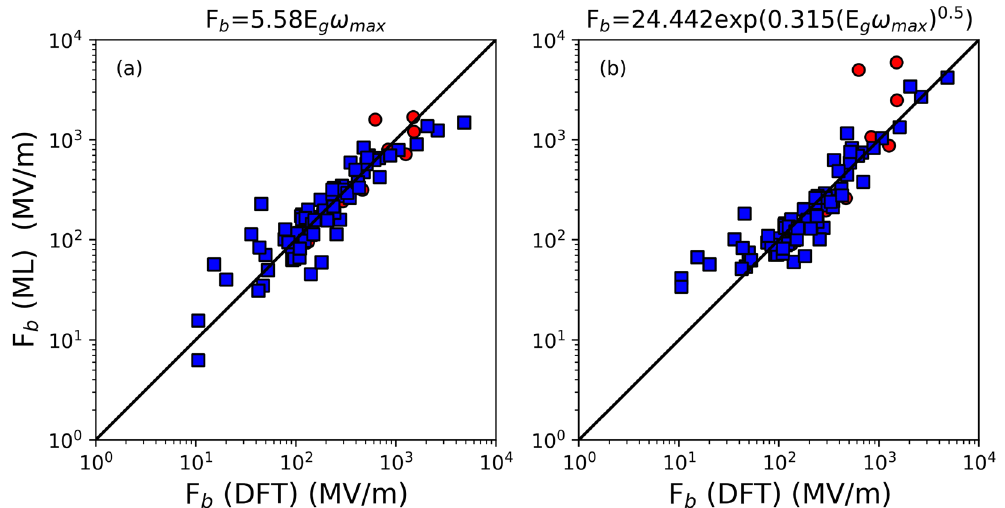
Figure 7. Dielectric breakdown strength F b predicted by machine learning and density functional theory (DFT) for ( a ) model with complexity 9 at Universal Pareto Frontier, ( b ) the LASSO solution. Blue squares represent the prediction for training and validation data and red circles represent the prediction for test data. The black solid line indicates a perfect match between machine learning and